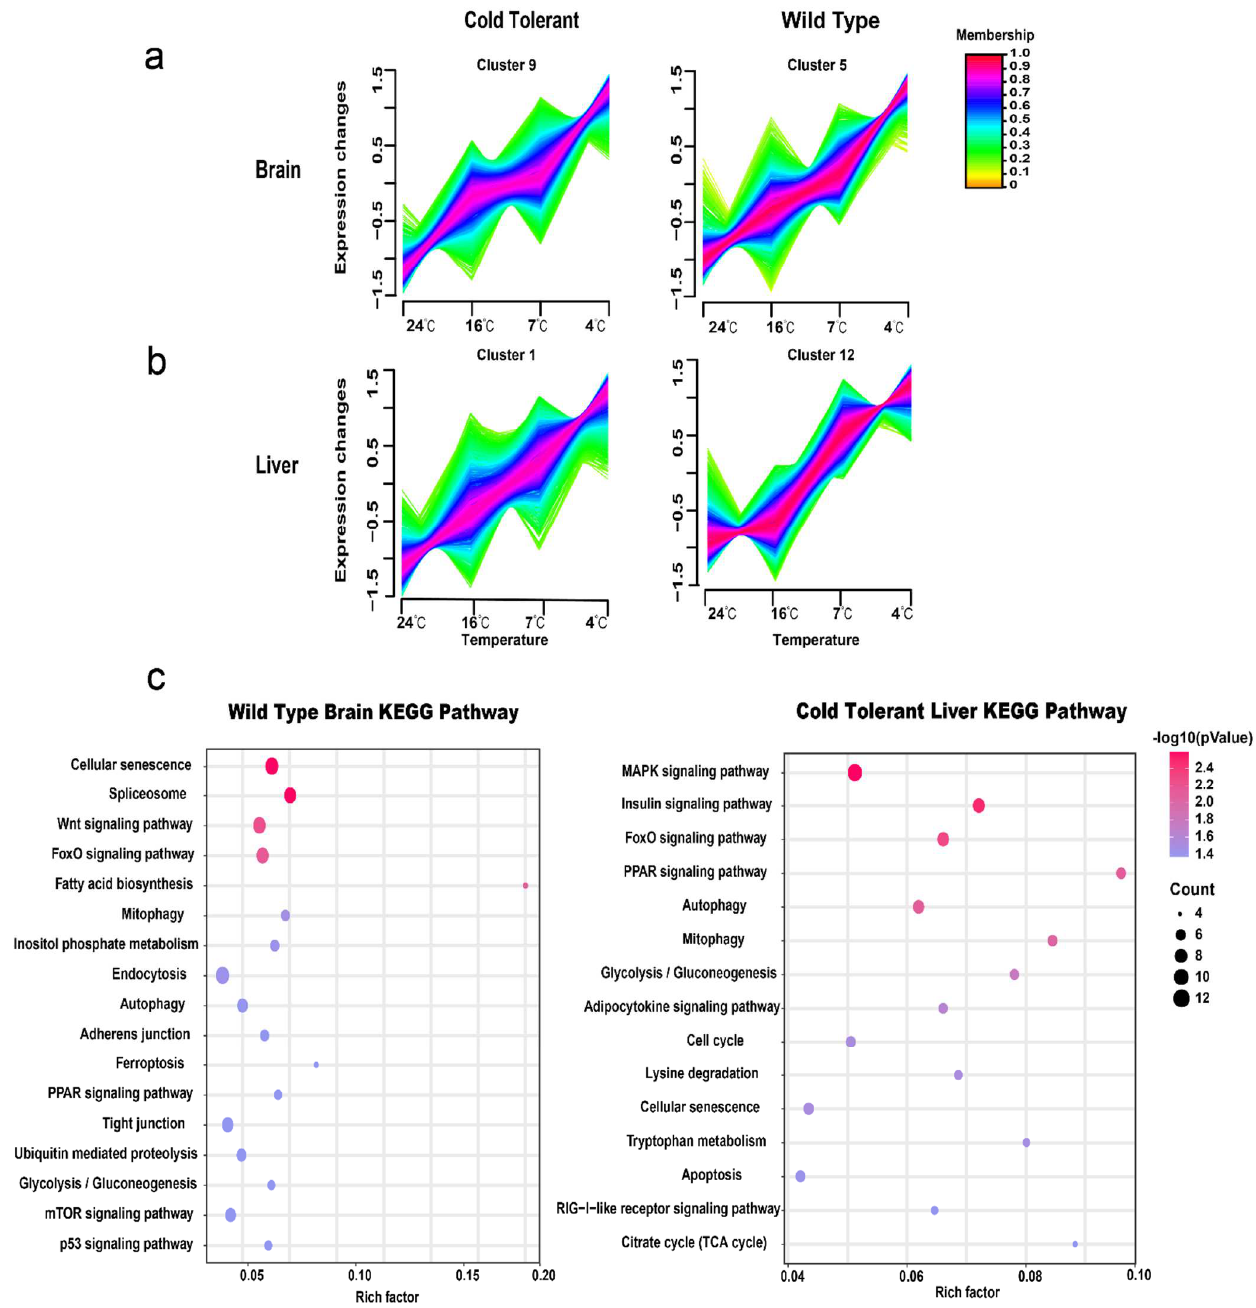
Figure 2. Global overview of differentially expressed genes at cold temperature in wild-type and cold-tolerant fugu. ( a , b ) Cluster analysis of differentially expressed genes in cold-tolerant fugu. KEGG pathway enrichments for the genes differentially expressed under cold stress. ( c ) Bubble plots indicate the enriched KEGG pathways for the wild-type of brain up-regulated (right-top panel) and cold-tolerant of liver up-regulated (right-bottom panel) genes. The Mfuss enriched up-regulated genes at different temperatures under cold stress in wild-type brain and cold-tolerant liver tissues were used for